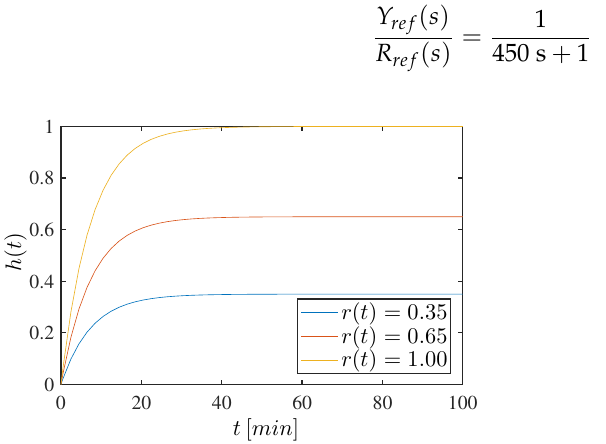
Figure 26. Reference model